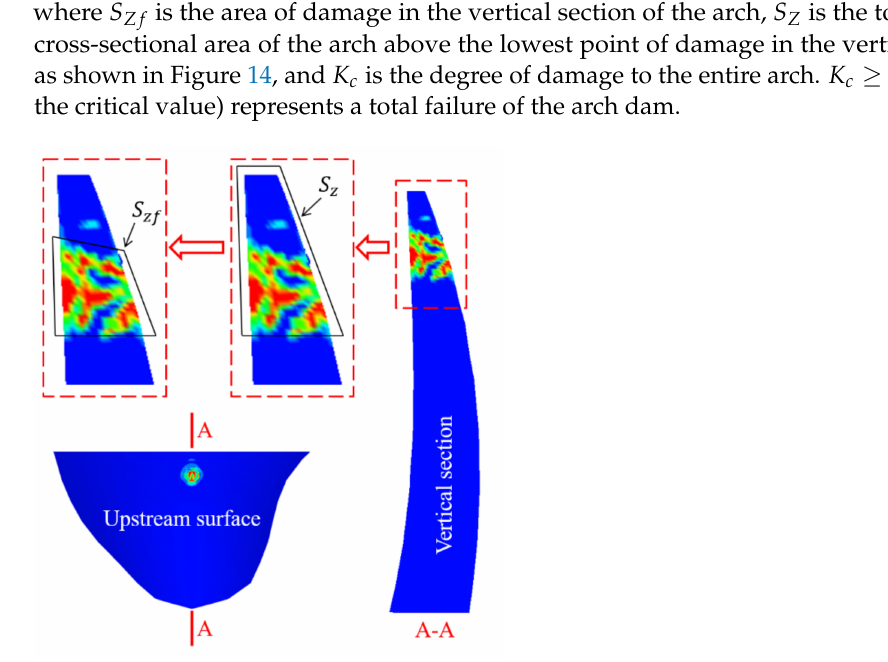
Figure 14. Schematic showing the parameters of the safety assessment of an arch dam with damage in the central part of the